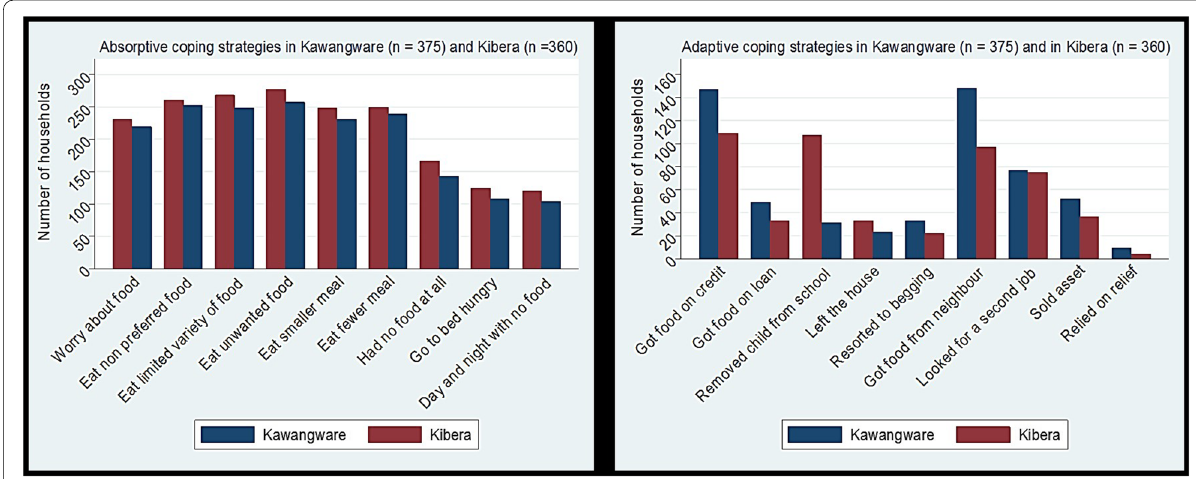
Fig. 3 Use of absorptive and adaptive strategies in the two